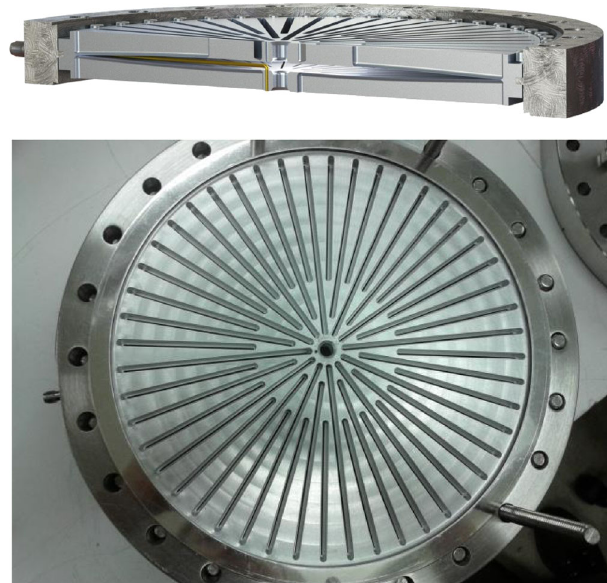
FIG. 1. Top: cut-away view of the harmonically resonant cavity. Bottom: photograph of the cavity nested inside the bore of a 10 ” double-sided knife edge Conflat flange. Two additional 10 ” Conflat flanges attach to either side to form the UHV-compatible vacuum